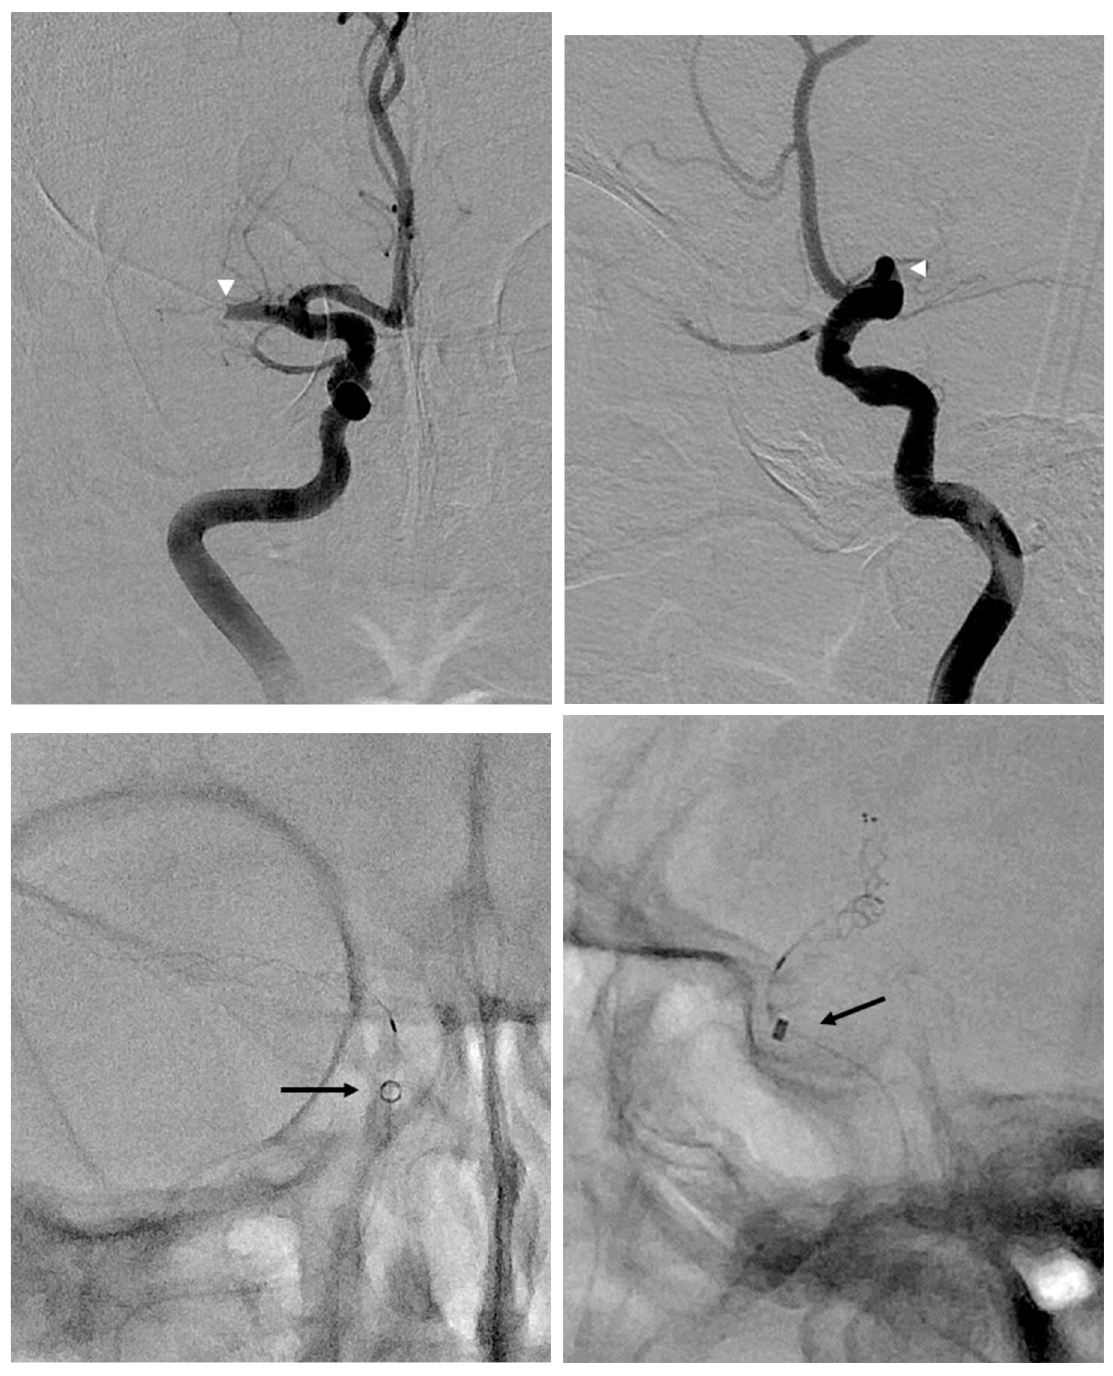
Fig 2. Distal access catheter (DAC) tip position during combined stent-retriever and aspiration technique in the proximal DAC group. (A, B) Right anteroposterior (A) and lateral (B) internal carotid artery angiogram images show occlusion of the right middle cerebral artery (arrowheads). (C, D) The DAC was placed in the cavernous ICA below the ophthalmic artery origin